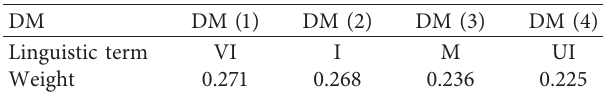
Table 24: The importance of decision-makers and their weights.